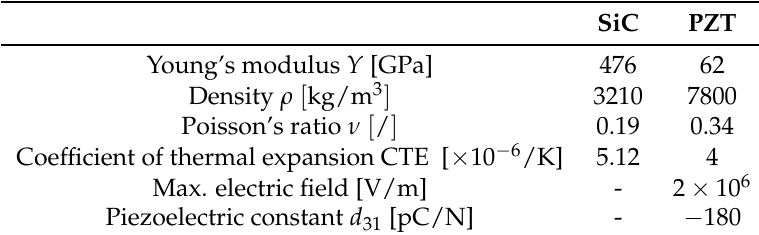
Table 1. Material data used in the